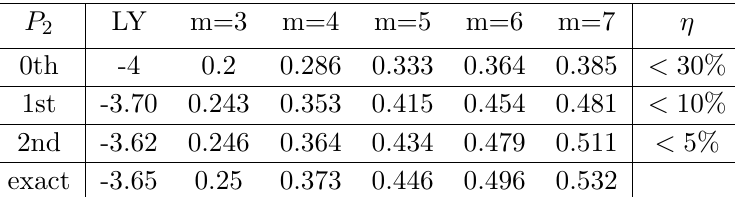
Table 3 . The estimates of the OPE coe(cid:14)cient P 2 at di(cid:11)erent approximation orders and their exact values. LY stands for the 2d Lee-Yang CFT. The parameters m indicate 2d unitary minimal models M ( m + 1 ; m ). We only show three signi(cid:12)cant (cid:12)gures. The estimates are more accurate at high orders. The relative errors (cid:17) ( i ) are de(cid:12)ned as j 1 (cid:0) P ( i ) =P exact 2 2